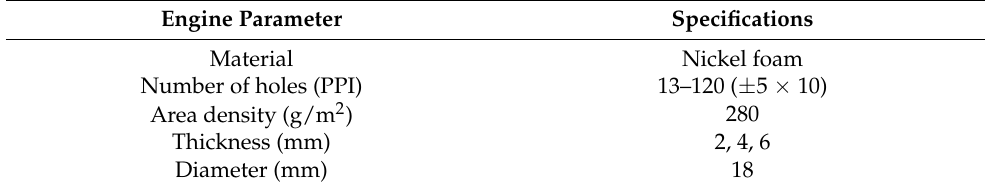
Table 2. Specification of Porous material.